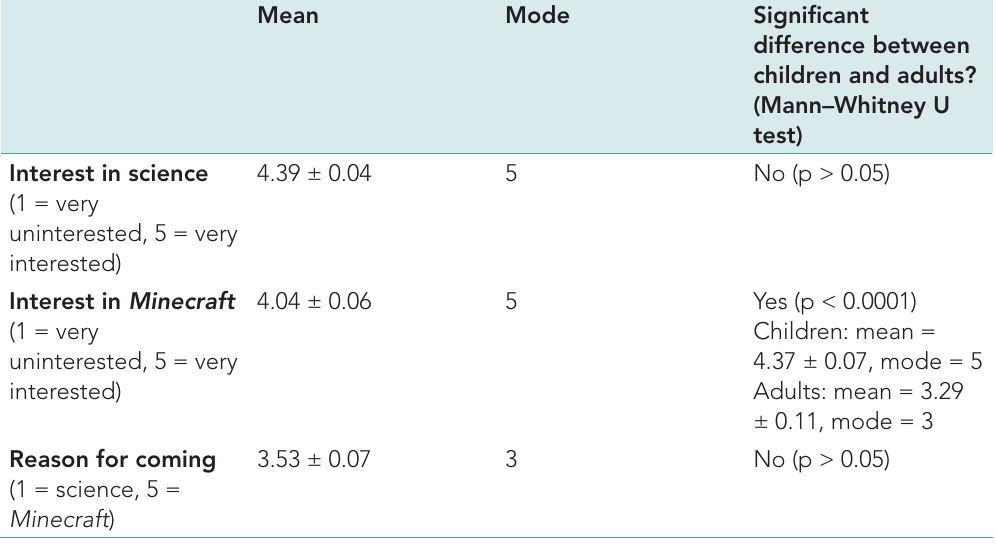
Table 3: Mean and modal values for interest in science, interest in Minecraft and reason for coming, for all attendees at all events, along with further breakdown for adults and children where a significant difference was found between these two